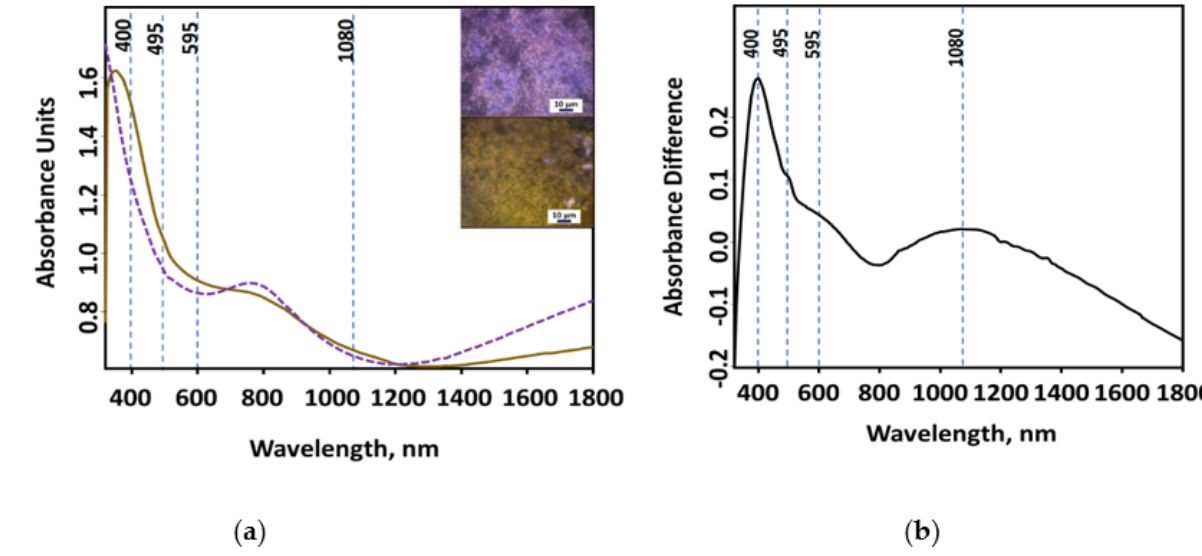
Figure 6. UV-Vis-NIR absorption spectra of the Ti 3 C 2 T x -based MXene film (dotted line) and salicylic acid (straight line) dried on the MXene ( a ); differential spectrum ( b ). Inset—optical microscope images of MXene film (left) and salicylic acid dried on the MXene film (right).